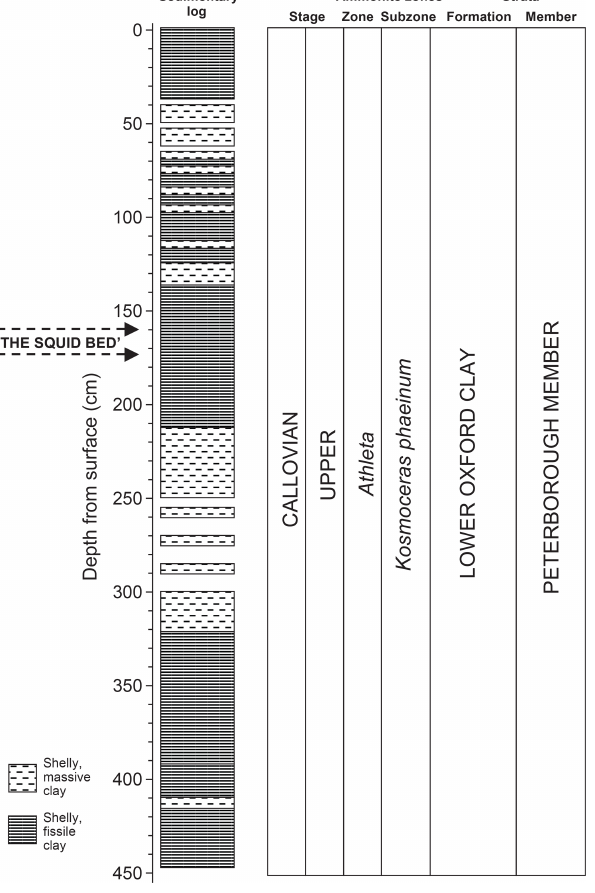
Figure 2. Core 10 sediment log, lithostratigraphy and biostratigra- phy. Gaps in the log indicate no, or very reduced, recovery. Adapted from Hart et al. (2016a) with